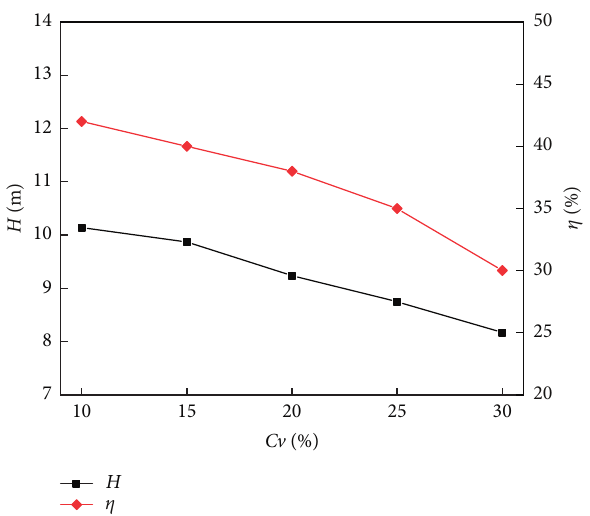
Figure 12: Influence of volume concentration on head and